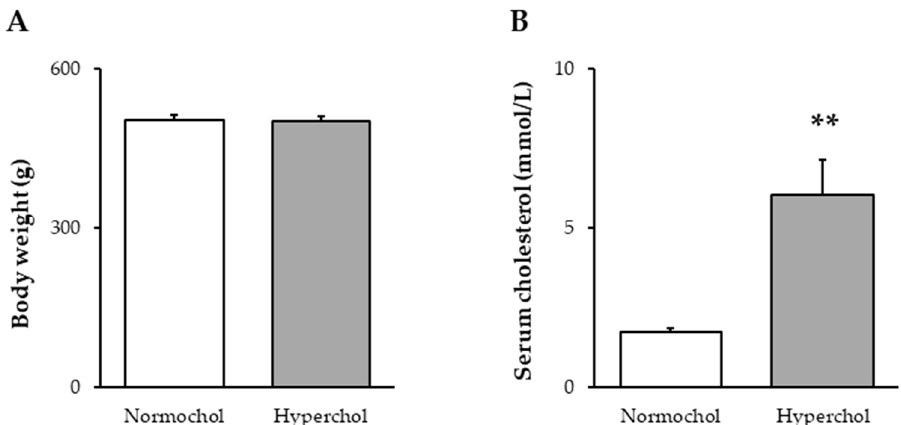
Figure 1. Body weight ( A ) and serum total cholesterol levels ( B ) at the end of 8 weeks of cholesterol diet. Data are expressed as mean ± SEM; n = 14–16. ** p < 0.01 vs. Normochol. Normochol and Hyperchol refer to normo- and hypercholesterolemia, respectively.